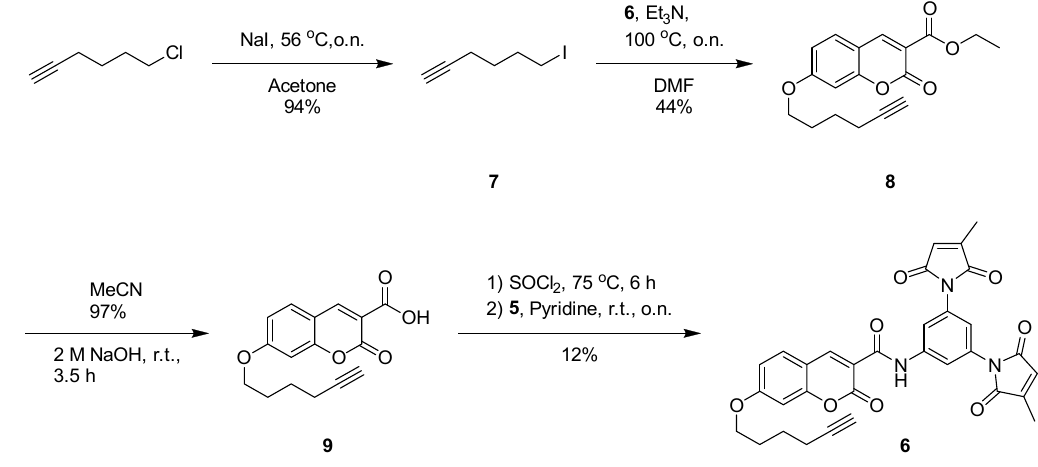
Figure 1. ( A ) Excitation (dotted line) and emission (solid line) spectra of 1 before (grey line) and after reacting with MBP-dC10* (black line). ( B ) Kinetic time course for the fluorogenic reaction between 10 µM of 1 with 10 µM of MBP-dC10* (black), relative to the stability of 1 in the absence of MBP-dC10* (grey). Rate constant k 2 = 245 ± 8 M − 1 s − 1 .